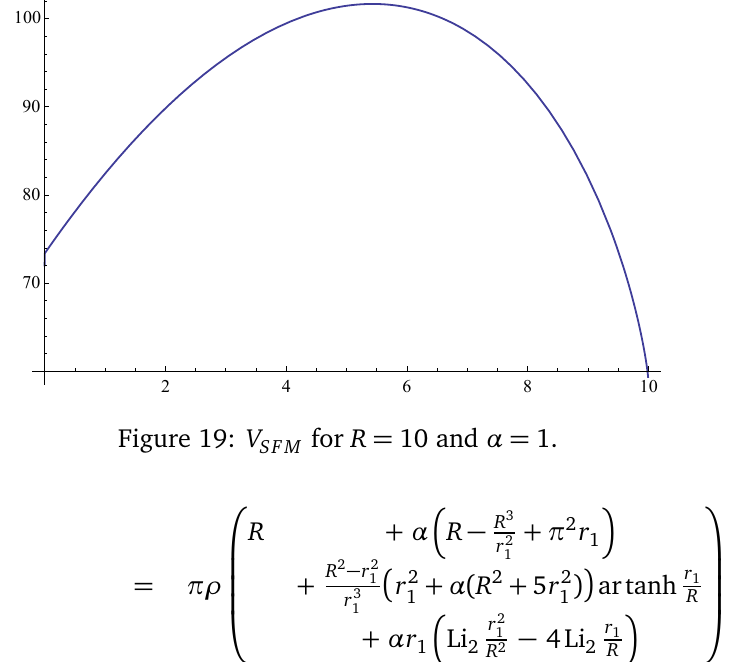
Figure 19: V for R = 10 and α = SFM